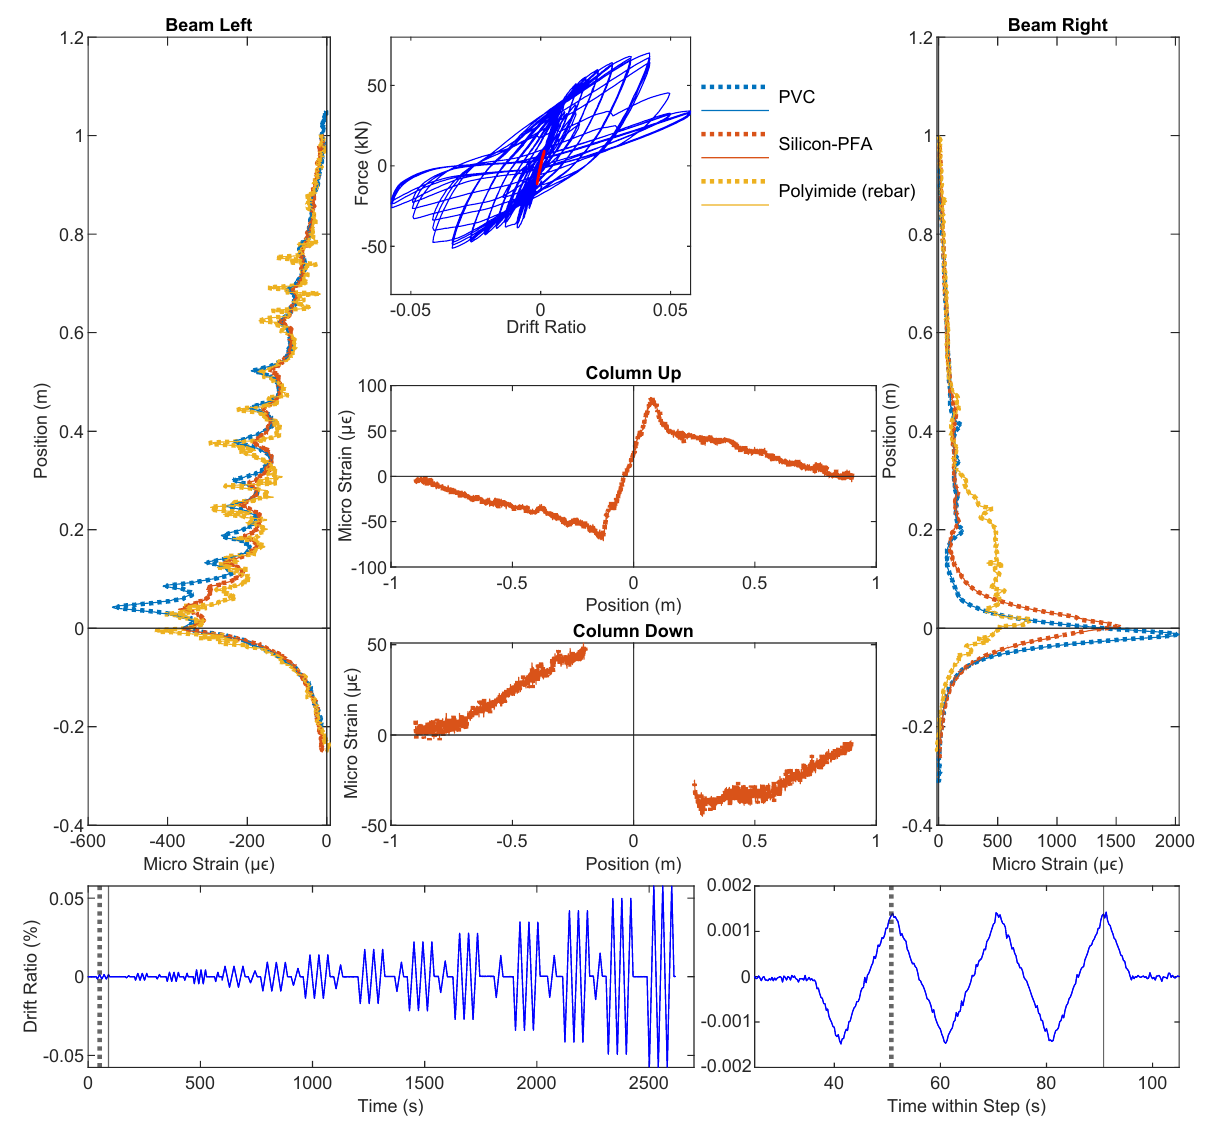
Figure 6. DFOS results at drift level of